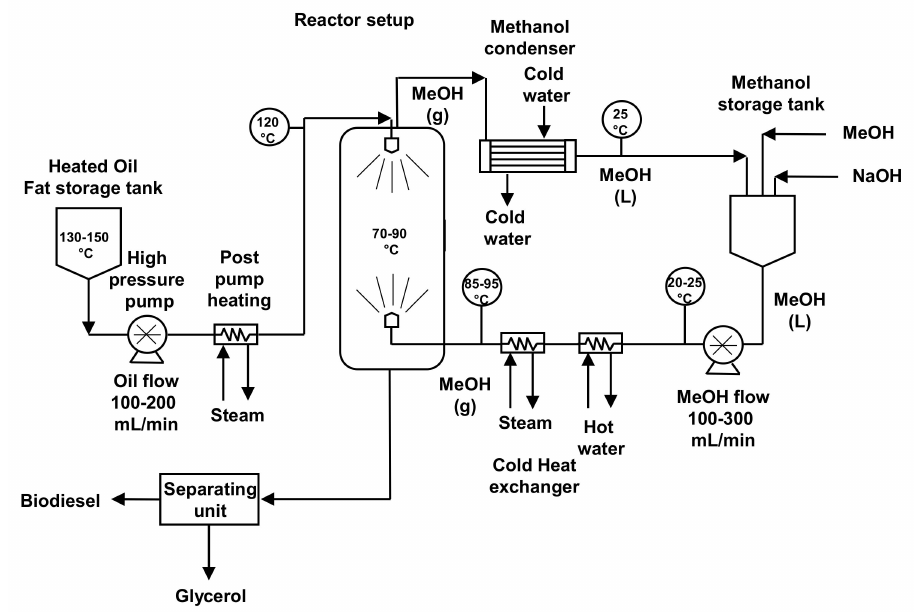
Figure 22. Continuous gas–liquid